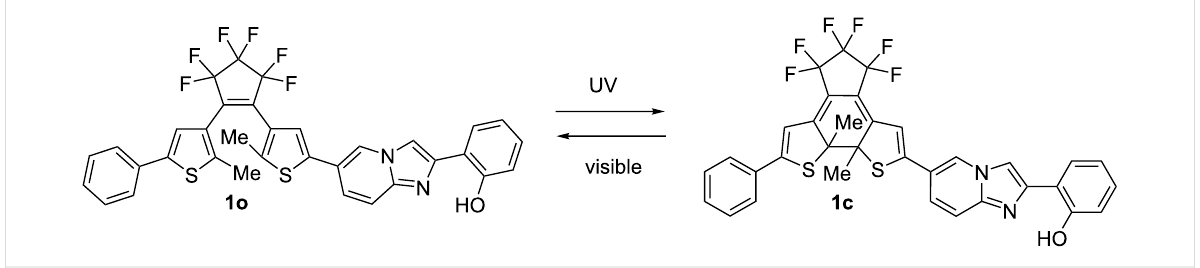
Figure 2: Photochromic reaction of diarylethene 1o having an ESIPT moiety.